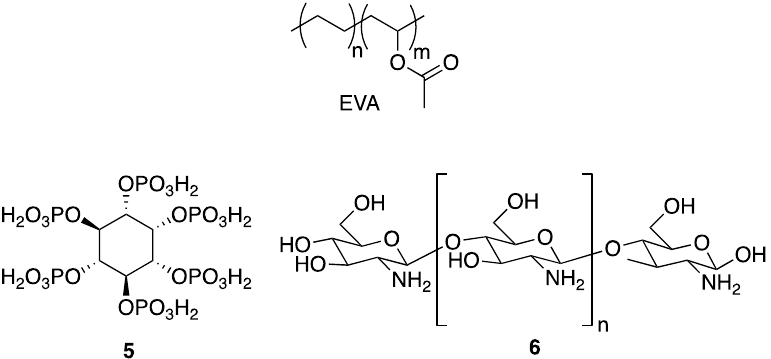
Figure 5. Molecular structures of ethylene-vinyl acetate (EVA), 5 , and 6.